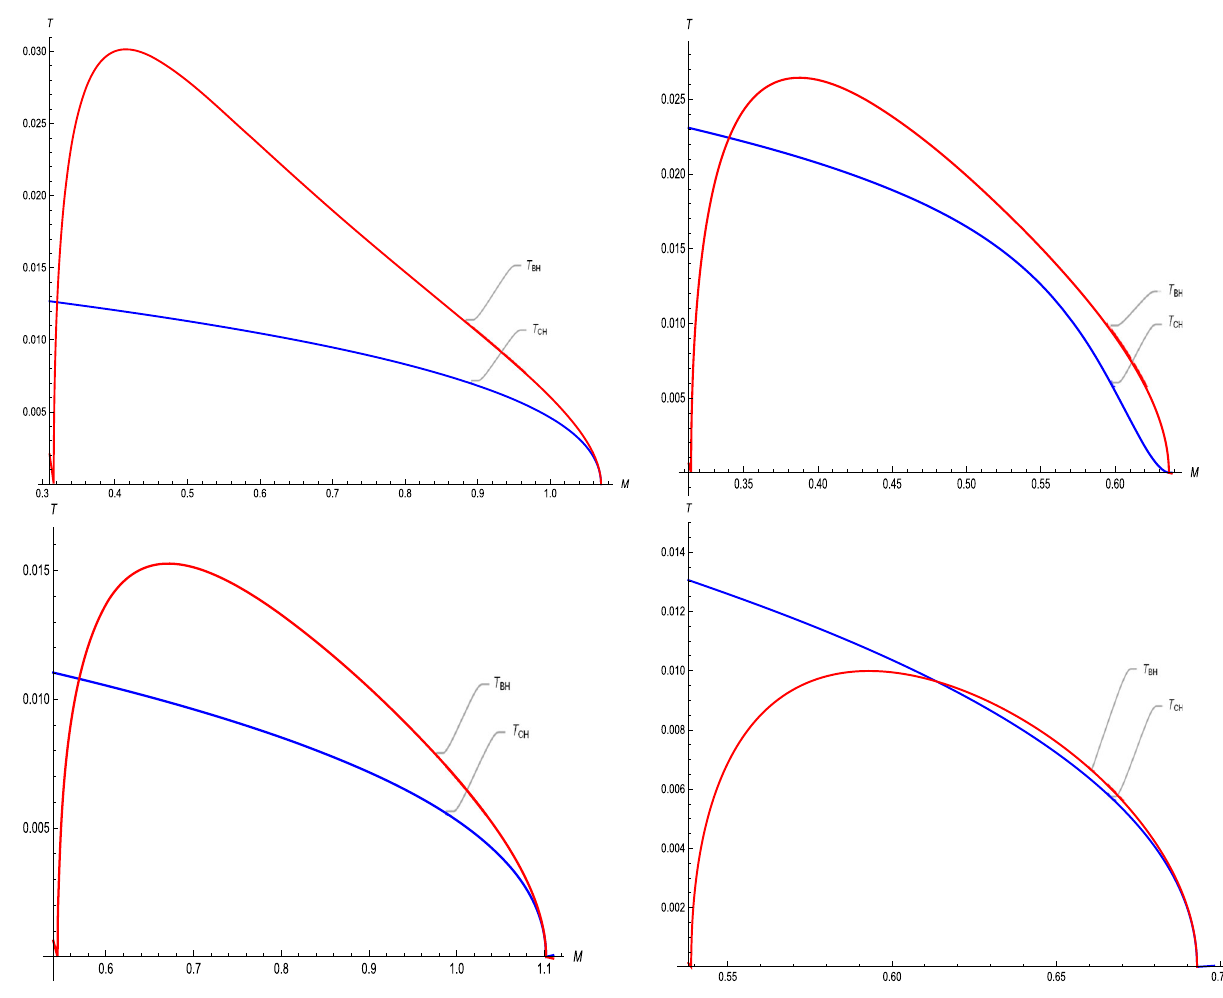
Fig. 8 Temperature of the black hole (red line) and cosmological (blue line) horizons for dS 4D EGB black hole versus the mass of the black hole. Plots have been depicted from top to bottom with α = 0 . 1 , 0 . 3